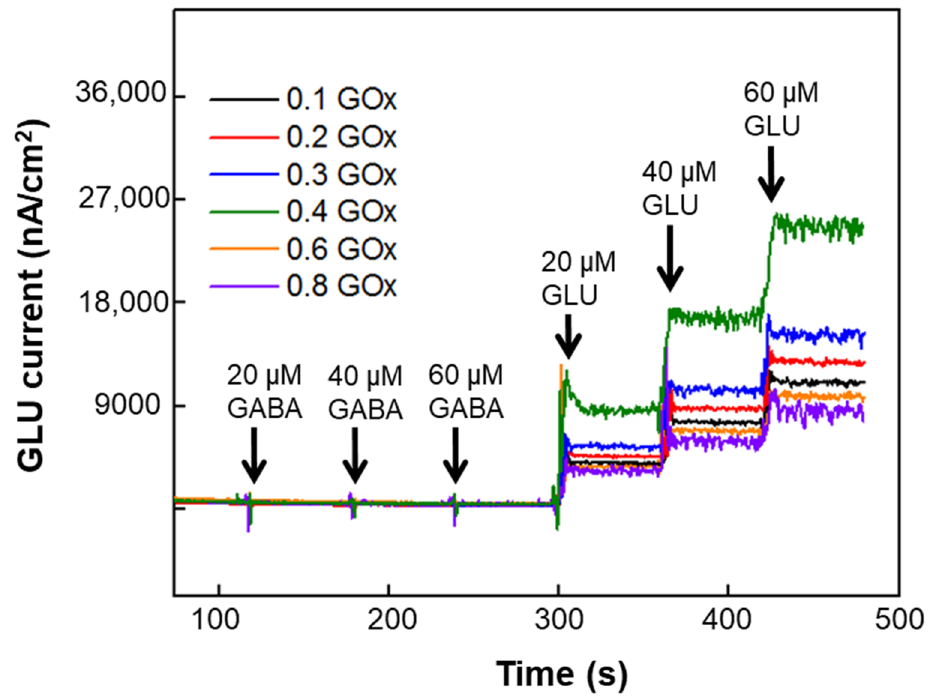
Figure 3. In vitro calibration of GLU microbiosensors at 0.1 to 0.8 U/ µ L GOx concentrations. Measurements were acquired in 100 µ M α -ketoglutarate +1X PBS with a 200-rpm stirring rate at 37 ◦ C. Amperometry parameters were +0.7 V vs. Ag/AgCl reference. A representative plot of the response of GABA and GLU (stepwise additions) at the GOx modified Pt UMEs. As expected, no current response to GABA and corresponding stepwise increases in current occurred with increasing GLU concentration. The sensitivity values of the GLU microbiosensors at increasing GOx were 167 ± 35, 199 ± 47, 266 ± 56,335 ± 67, 200 ± 36, 181 ± 29 nA μ M − 1 cm − 2 . Values were shown in mean ± SEM. (one-way ANOVA, p < 0.05).